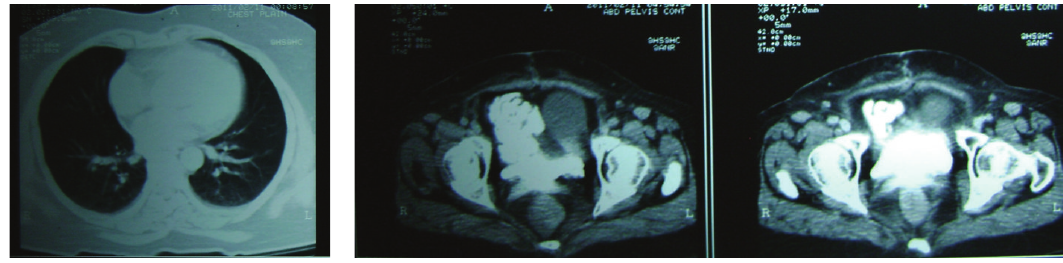
Figure 3: CT scan after 4 weeks following 6 cycles.